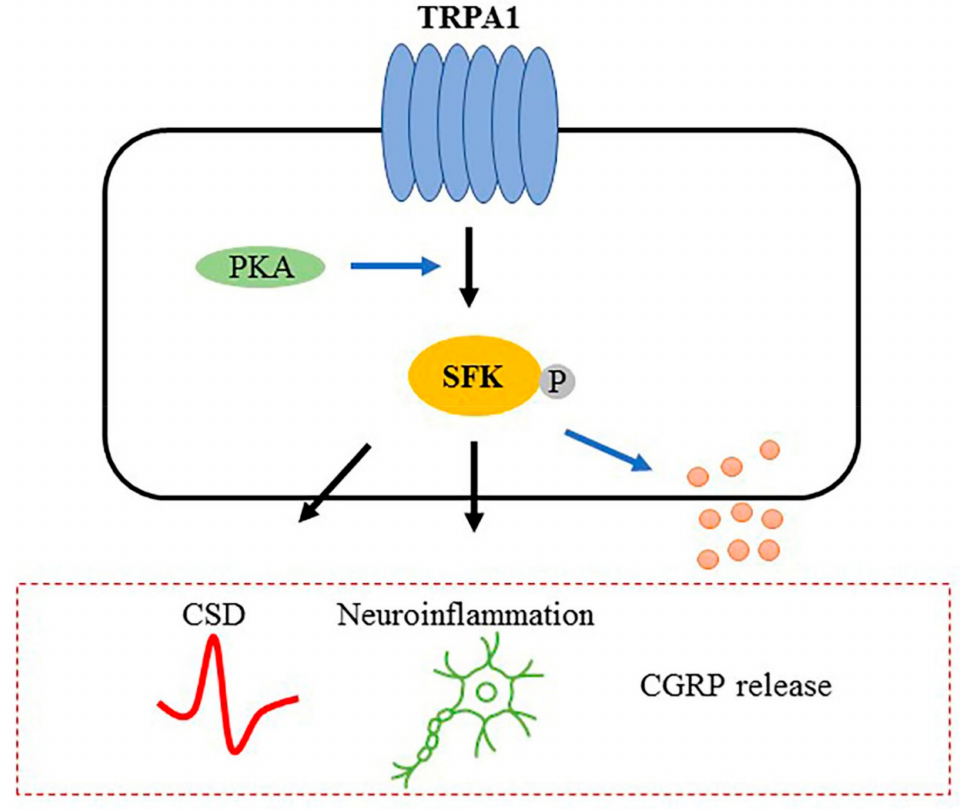
Figure 7. Schematic representation of the proposed TRPA1/SFKs signaling-mediated migraine pathogenesis. TRPA1/SFKs pathway involving PKA contributes to migraine pathogenesis from multiple aspects, including cortical susceptibility to CSD, CGRP release and